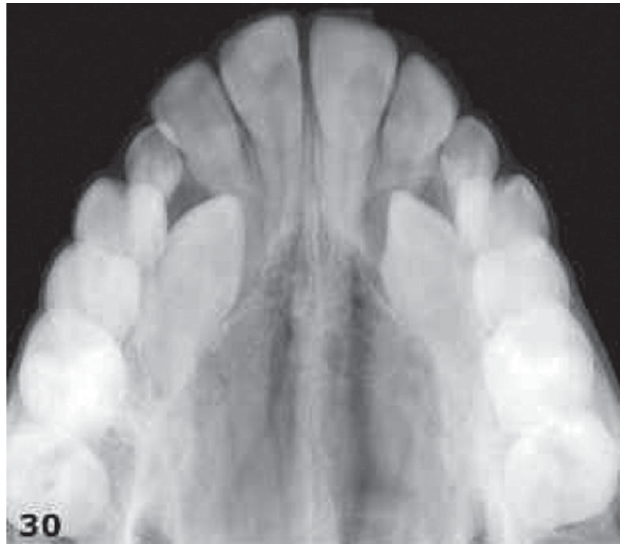
Fig. 3: Occlusal film to identify canine position.